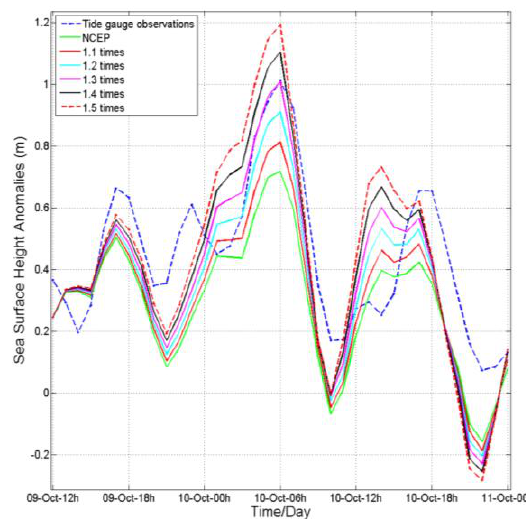
Figure 4. Sea level anomalies comparison between observations and simulations at Xiamen.